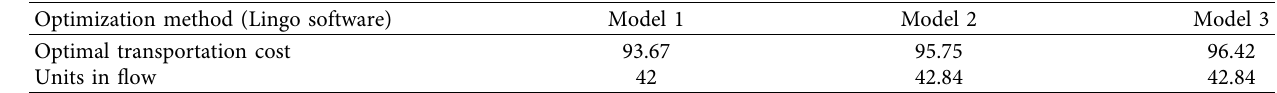
Table 4: Computational results for 3 models.